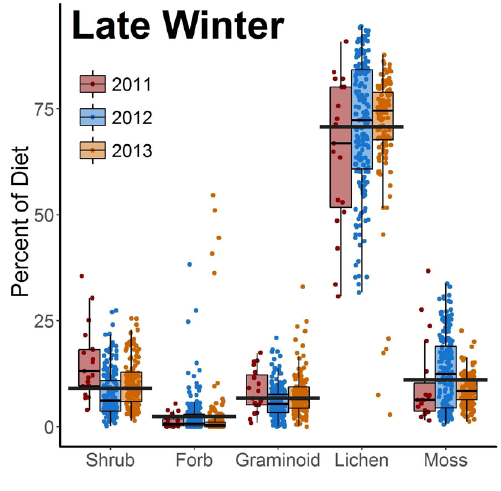
Figure 3. Late winter diets (February-April) of adult caribou in northwest Alaska, 2011-2013. The thin bar inside the boxplots represents the median. The thick bar spanning all 3 years represents the 3-year